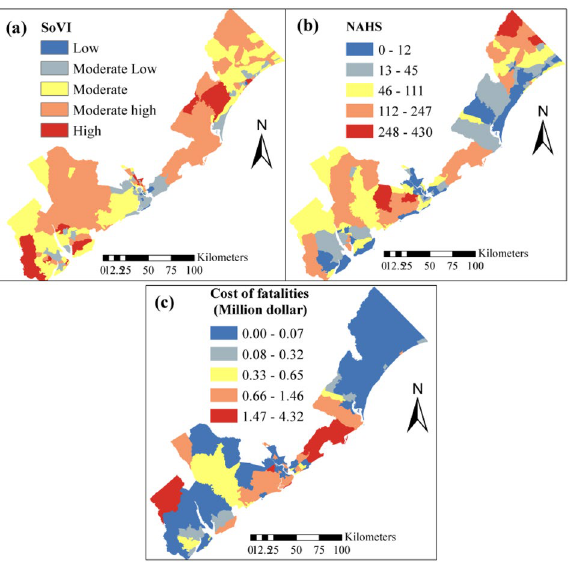
Figure 6. Socio-economic vulnerability indicators ( a ) Social Vulnerability index, ( b ) no. of Archeological and Historical structures (NHAS), ( c ) cost of